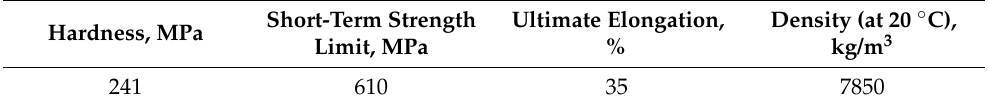
Table 4. Mechanical properties of steel